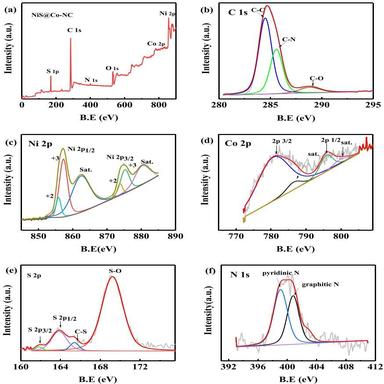
XPS spectra of NiS@Co-NC nanosphere: (a) full spectrum, (b) C 1s, (c) Ni 2p, (d) Co 2p, (e) S 2p, and (f) N 1s.